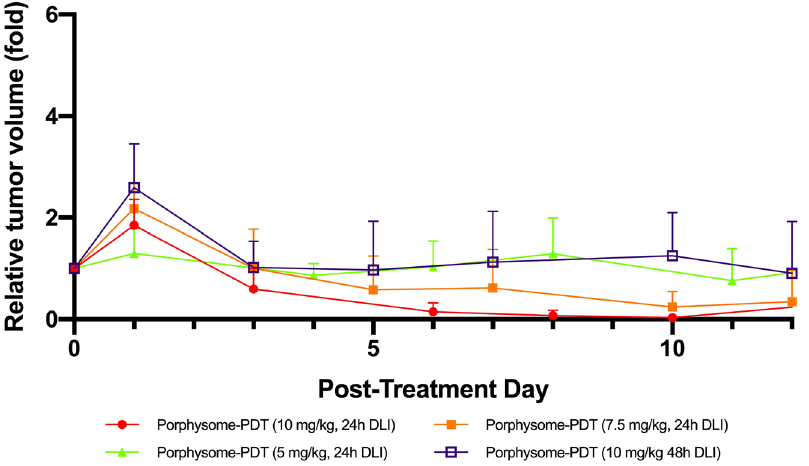
Figure3: Relativetumorvolumeacrossdose- finding groups with 12 days of follow-up. Mean ± 1 S.D. with half bars shown for clarity.